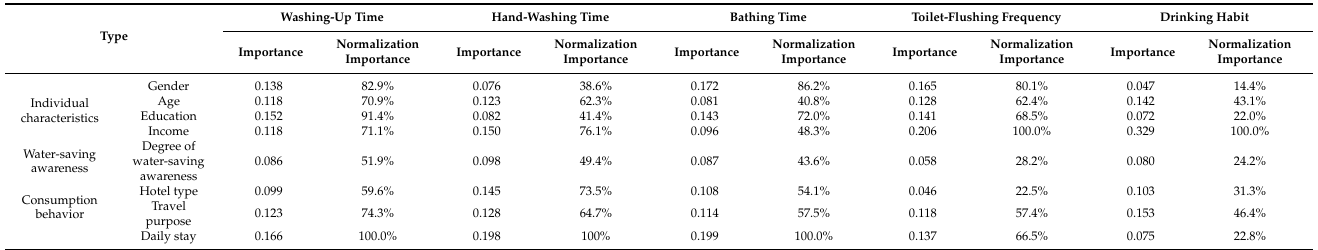
Table 4. Importance of influencing factors of water-consumption behavior in the hotel.